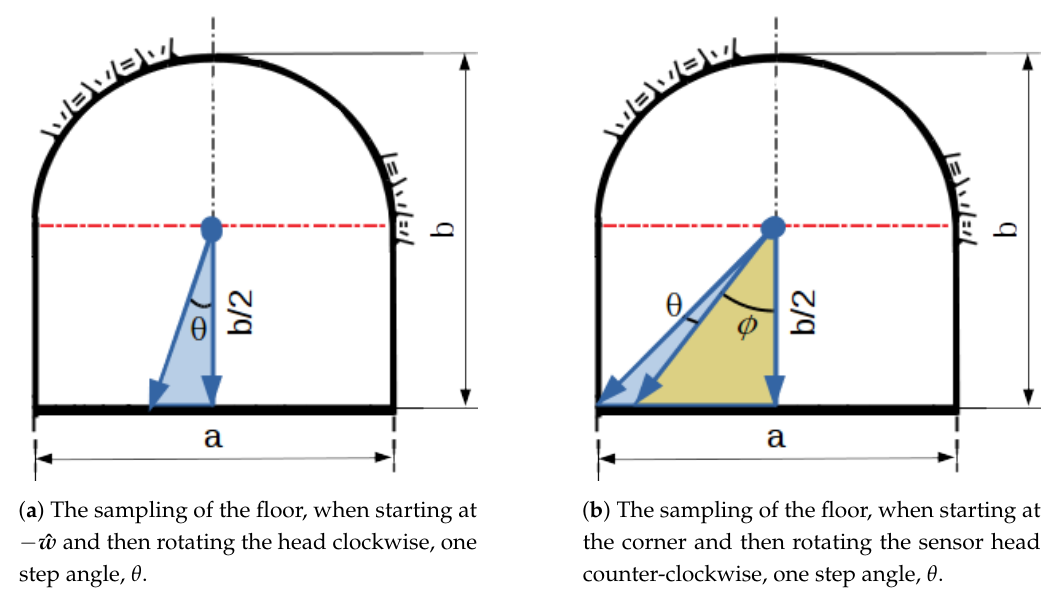
Figure 3. Analysis of floor samples in the two extreme cases: ( a ) when the sensor is centered and perpendicular to the floor; and, ( b ) when the sensor hits the